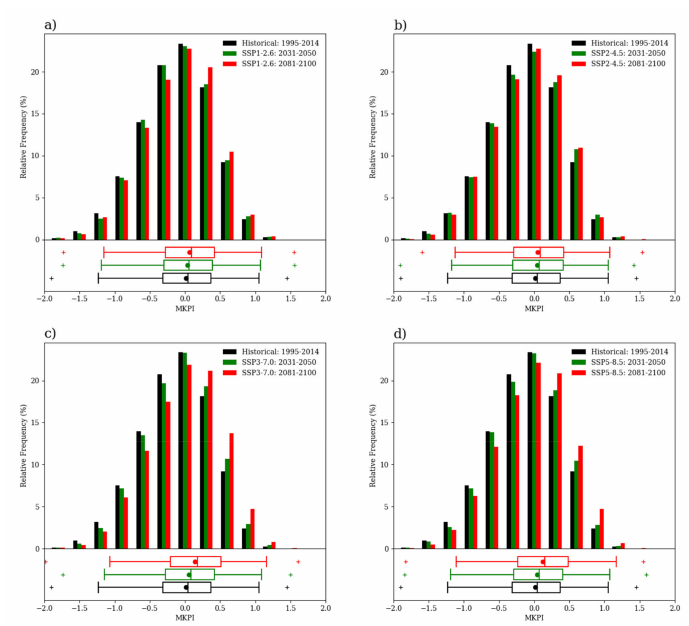
Figure 7. Similar to Figure 6 but projected for the near-term future (green bars and boxplots, 2031–2050) and long-term future (red bars and boxplots, 2081–2100) of the MKPI on the shared socioeconomic pathway (SSP) scenarios of SSP1-2.6 ( a ), SSP2-4.5 ( b ), SSP3-7.0 ( c ), and SSP5-8.5 ( d ) with the historical present (black bars and boxplots, 1995–2014).